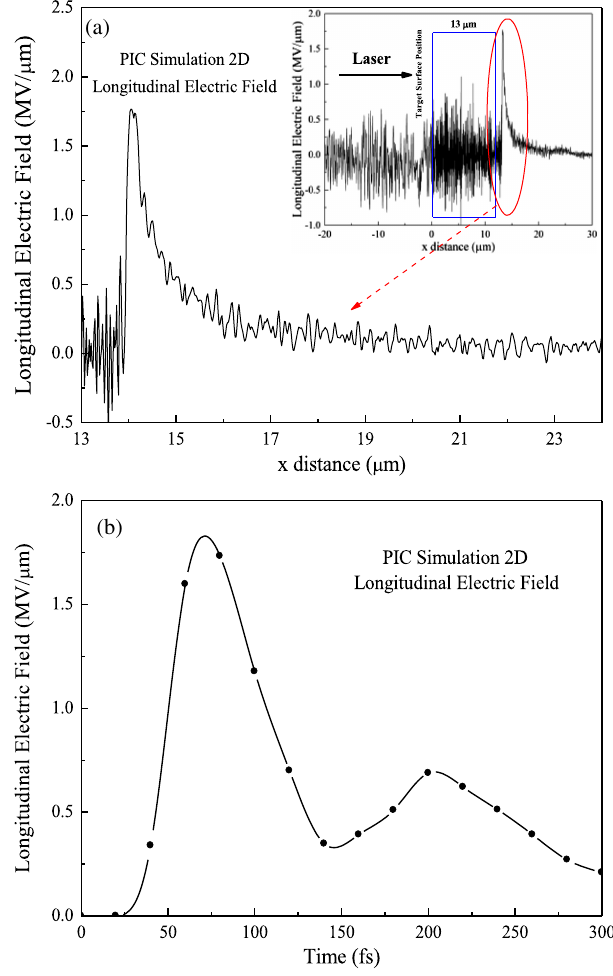
FIG. 5. Longitudinal electric field versus distance from the target surface, evaluated from PIC code as closeup and normal figure (inset) (a) and as a function of the time in the position of maximum value ( 14 μ m)